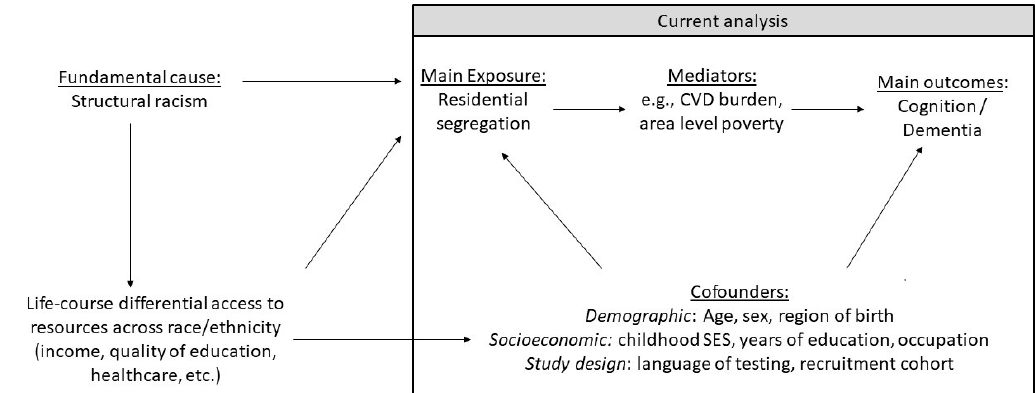
Figure 2. A conceptual and analytical model of the relationships studied. Residential segregation was measured by 6 indices at the census block group level. To test if the association of residential segregation varied based on respondent race/ethnicity, effect modification was examined by including individual-level race/ethnicity × segregation term.